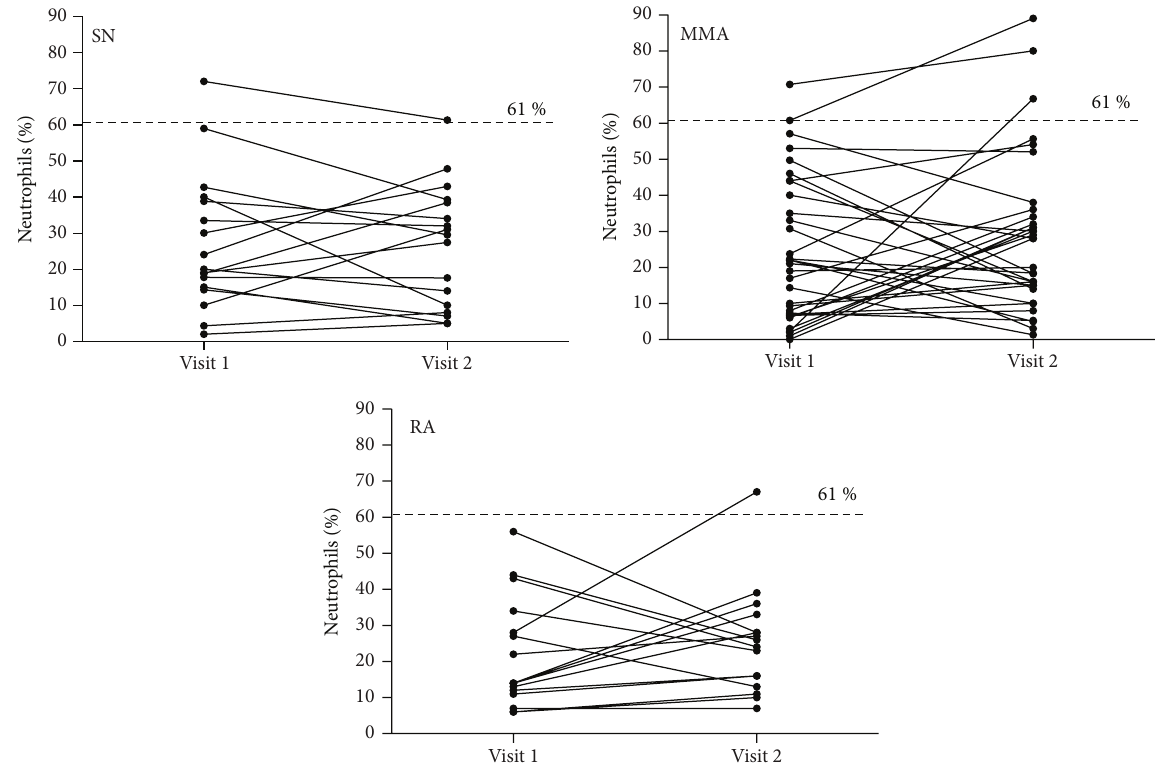
Figure 3: Changes in sputum neutrophils count in studied asthma cohorts: steroid-na¨ıve asthma (SN), mild to moderate asthma (MMA), and refractory asthma